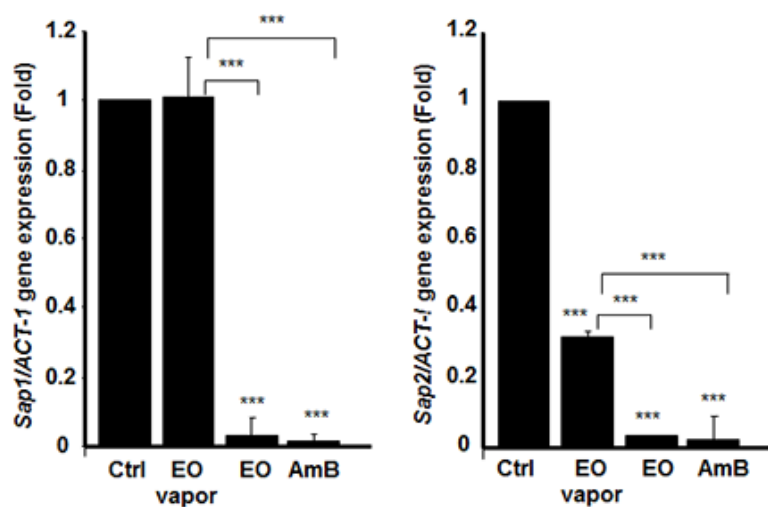
Figure 6. Mentha × piperita essential oil decreased SAP1 and SAP2 gene expression. Following C. albicans culture in the presence or absence of 10 µ L/mL of EO or its vapor, or AmB (1 µ g/mL) for 6 h at 30 ◦ C, total RNA was extracted from each cell culture and qRT-PCR was performed using specific primers for SAP1 or SAP2 . ACT-1 was used as the housekeeping gene for internal control. The plotted values refer to the ratio gene of interest /ACT-1. The changes in mRNA levels are presented as the fold expression of the gene in the test sample compared with this gene’s expression in the control (without EO). Results are expressed as the means ± SD, n = 3. *** p < 0.001. The free asterisks refer to the statistical difference when comparing EO effects to control. The bars with asterisks showed the comparison of EO vapor to the EO liquid, and to the AmB.